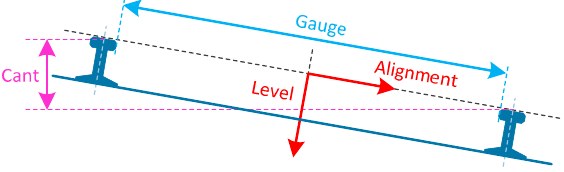
Figure 1. Track coordinate system and geometry parameters.